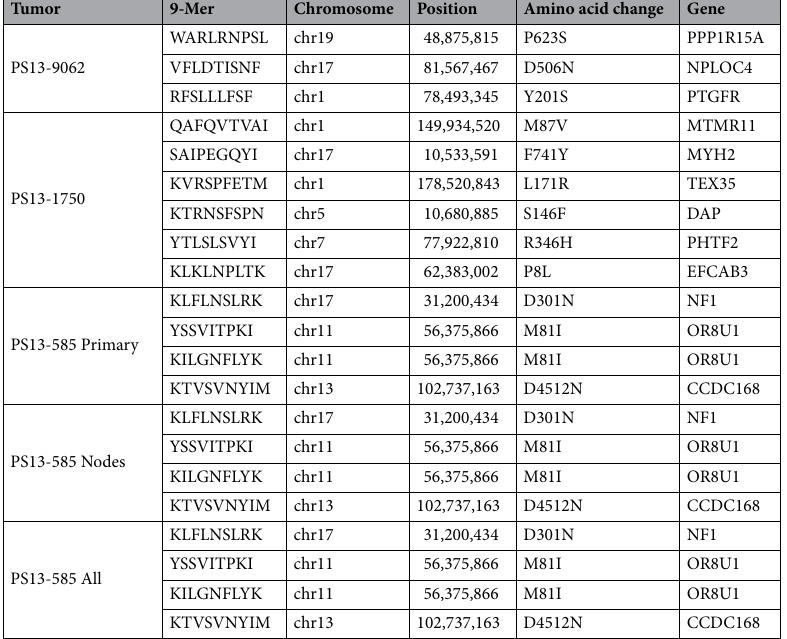
Table 1. Predicted shared